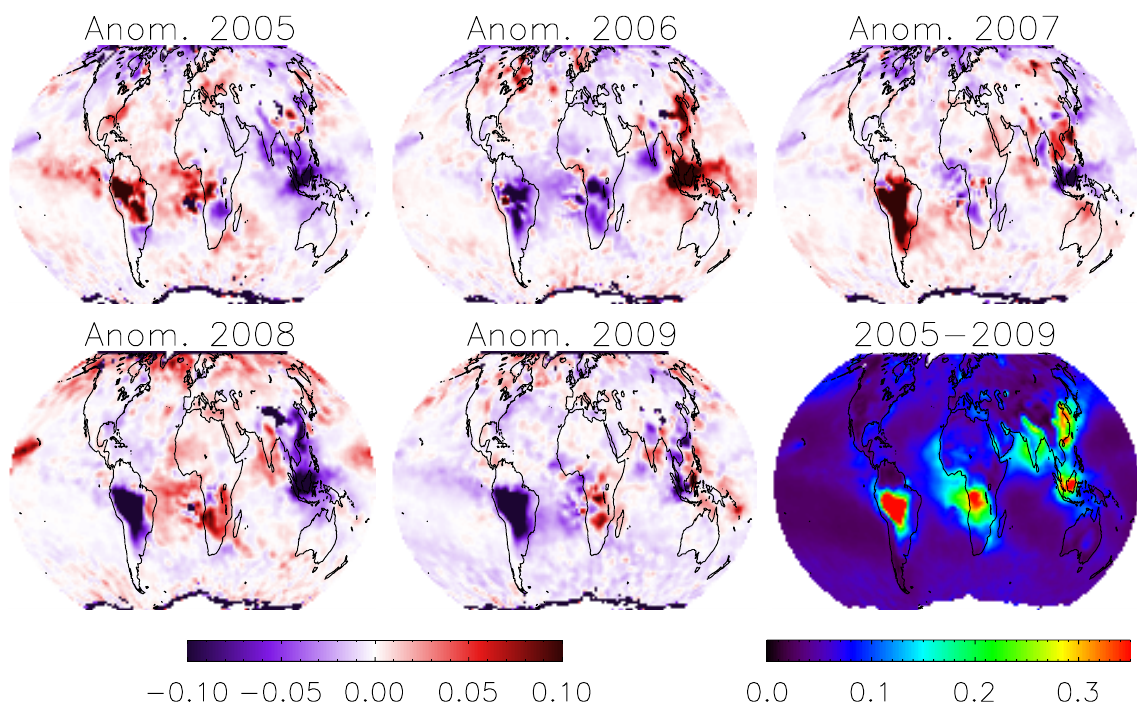
Fig. 2. AOD at 550nm resulting from the accumulation mode averaged over three months September–October–November and the 5yr (bottom right). (a) to (e) AOD anomalies for the 5yr from 2005 to 2009 respectively. Blues indicate that the AOD of the year was lower than the long term mean and reds indicate higher